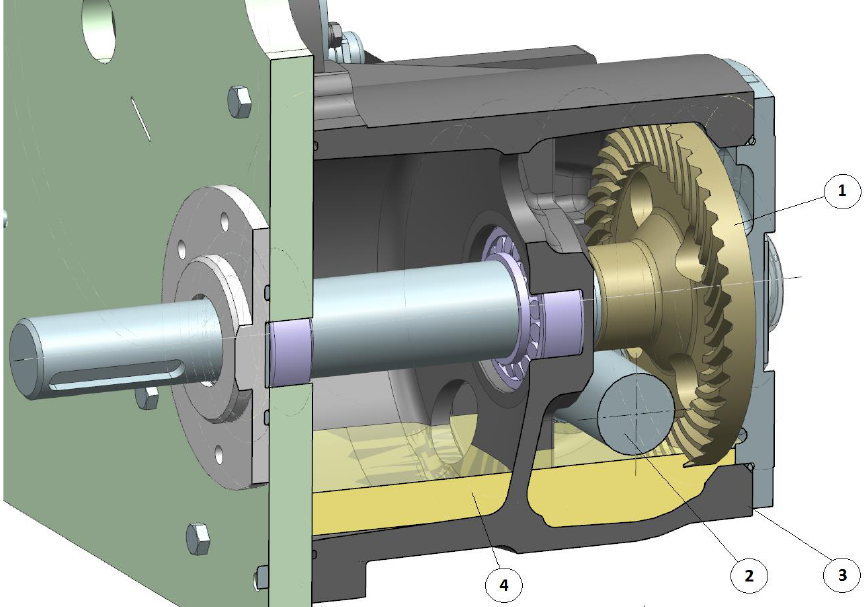
Figure 6. Immersion lubrication of spiroid gear; 1 — face gear, 2 — worm, 3 — casing, and 4 — oil. Immersion lubrication uses the rotation of the worm and face gear immersed in oil. The worm tooth should be immersed in oil to the depth of 3 m , where “m” is the normal module. The rotating input shaft delivers oil to the mating worm threads and the worm wheel teeth. The splash delivers oil to the rolling bearings. Where the peripheral speed of the worm exceeds 8 m/s, the spray lubrication method should be used (Figure 6) [29].